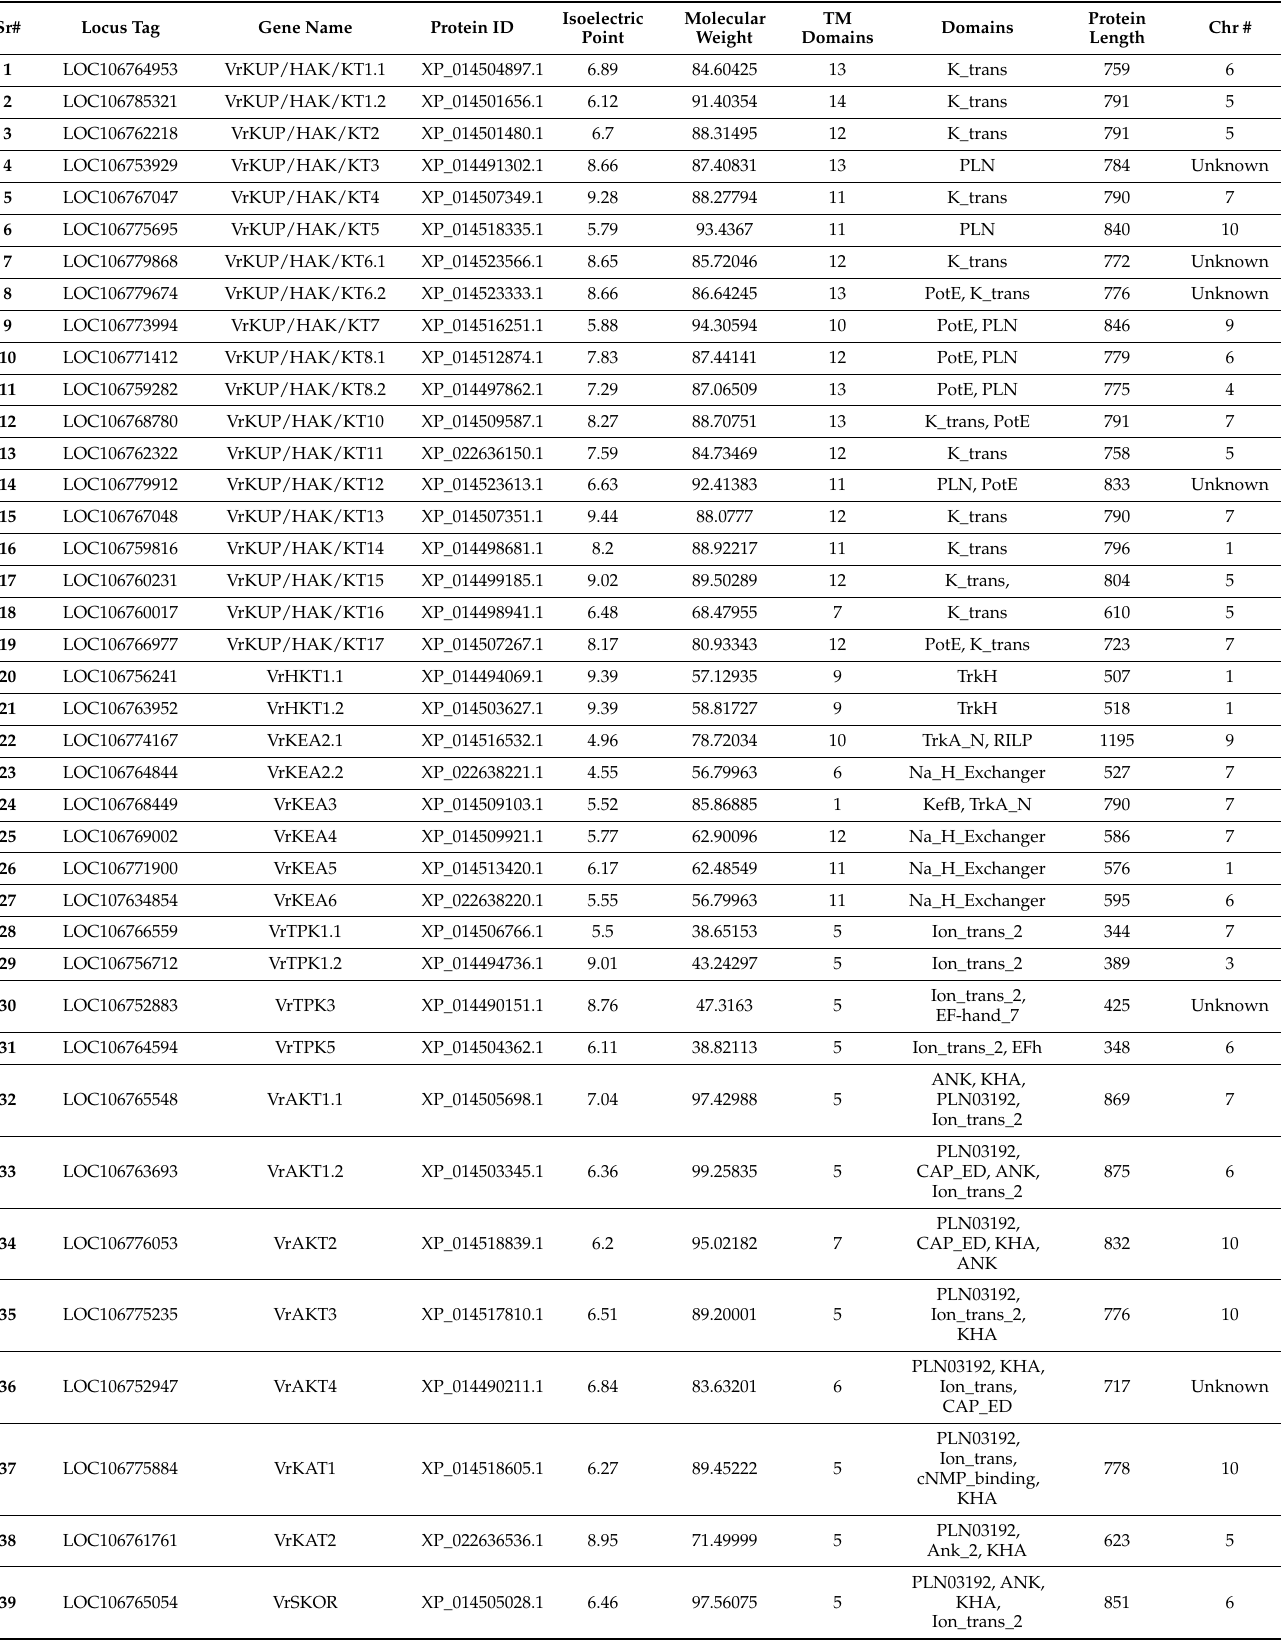
Table 1. Overview of the sequence features of potassium transport